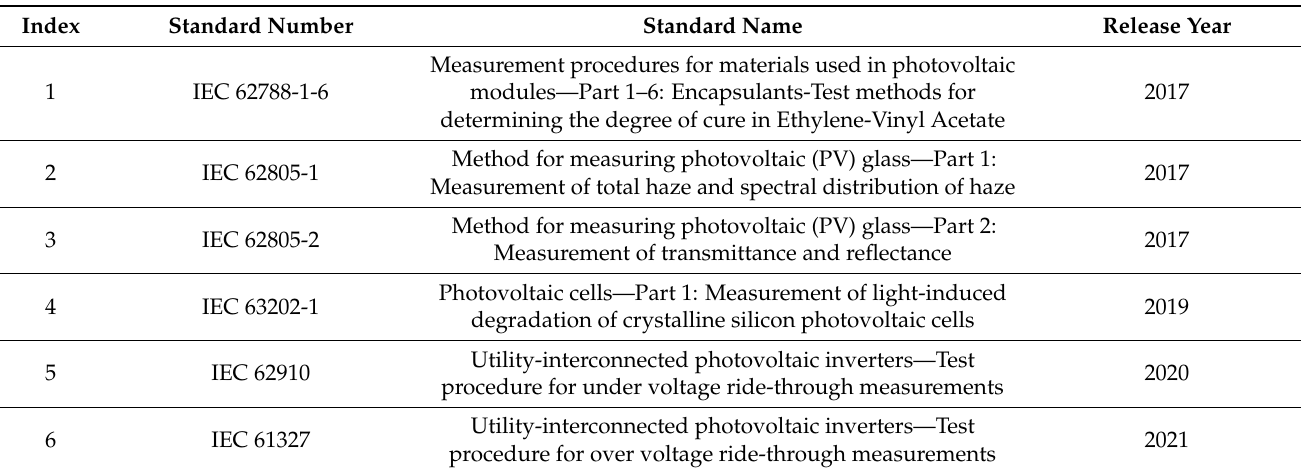
Table 3. Published IEC international standards dominated by